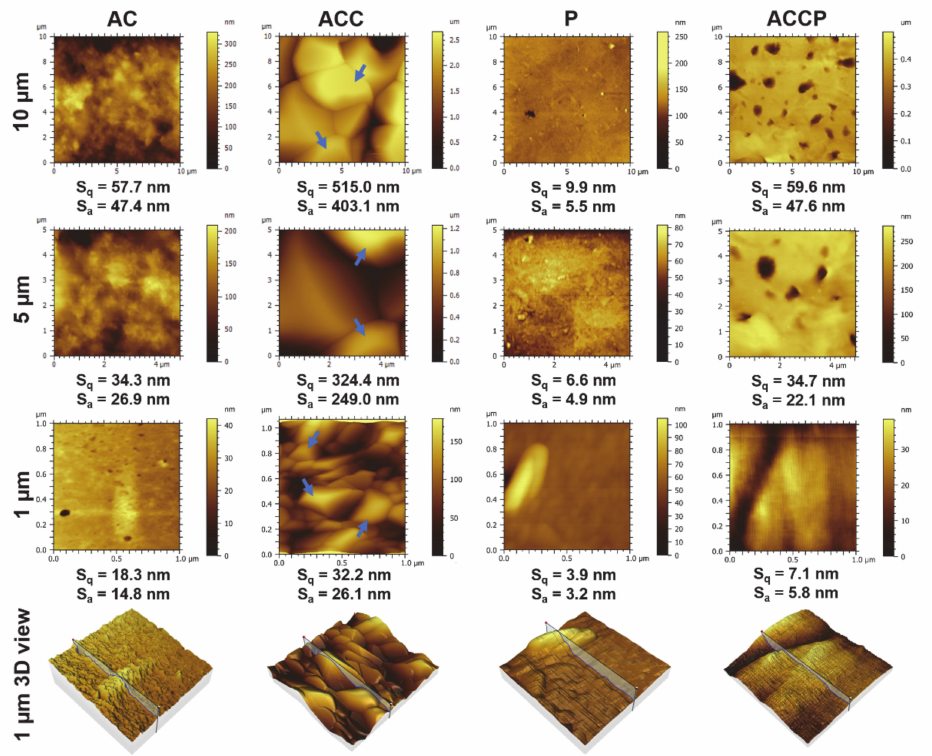
Figure 2. Scaffolds’ surface morphology and roughness parameters as measured by atomic force mi- croscopy. The arrows indicate CaCl 2 crystals on the surface of crosslinked alginate and carboxymethyl cellulose (ACC) scaffolds. P, pure polycaprolactone scaffold; ACCP, scaffold with alternating layers of ACC and